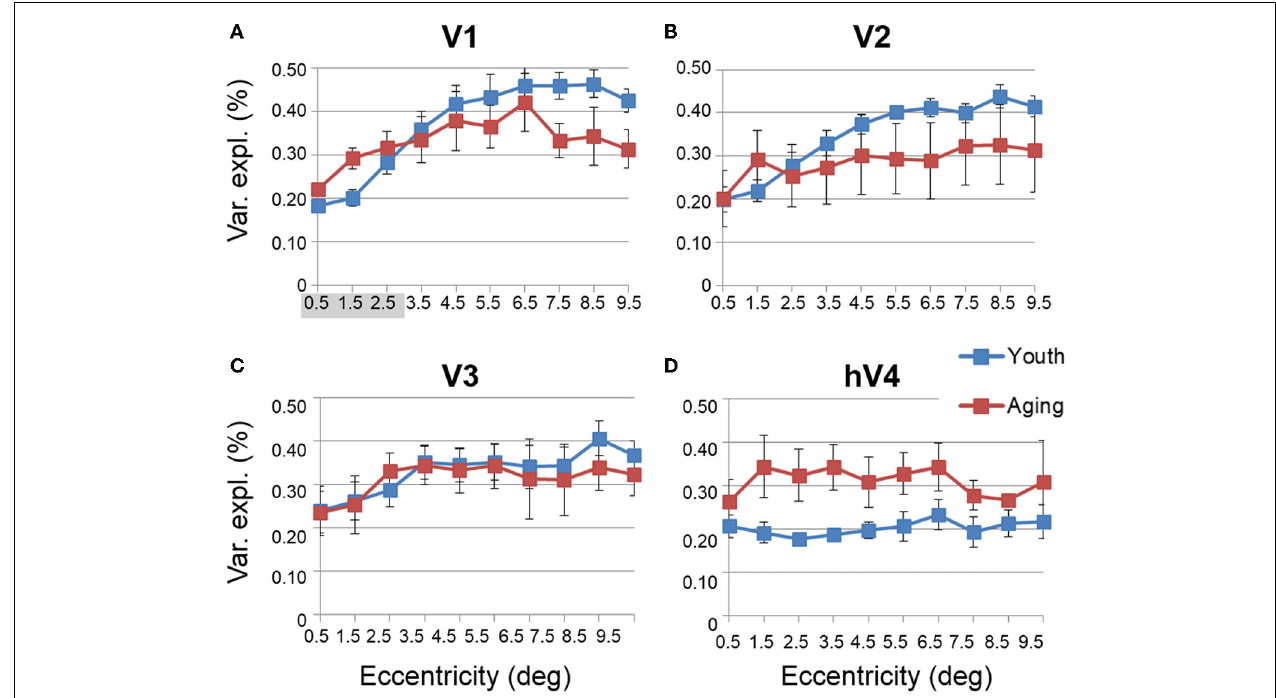
FIGURE 7 | Average measurements of percent variance explained for visual field maps in young and healthy aging subjects. (A) V1. (B) V2. (C) V3. (D) hV4. Blue lines represent data from healthy young subjects, and red lines represent data from healthy aging subjects. Each bar represents data measured in individual subjects